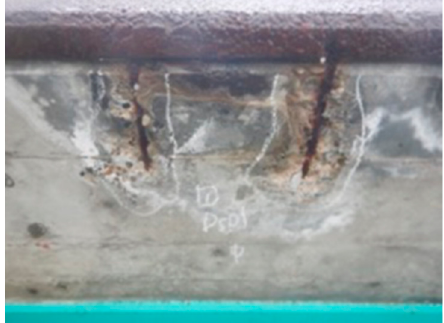
Figure 1. A typical picture of delamination (with rebar exposure).